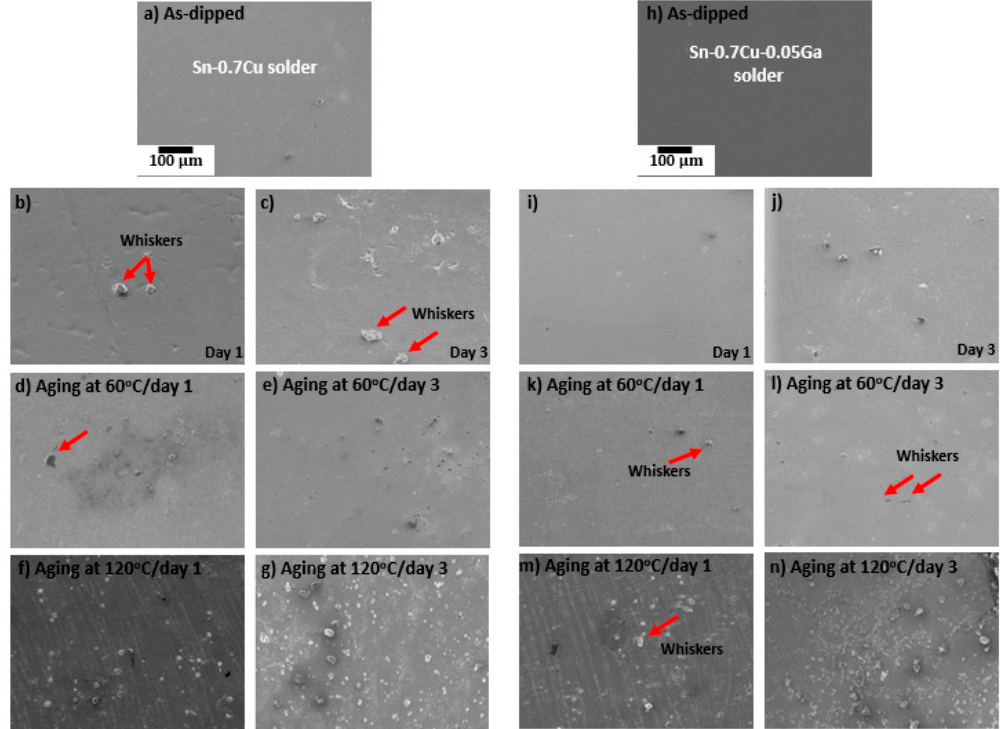
Figure 9. Whisker growth on Sn–0.7Cu: ( a ) as-dipped solder; after day 3 electromigration testing ( b , c ); after thermal ageing at 60 °C on day 1 and day 3 ( d , e ); after thermal ageing at 120 °C on day 1 and day 3 ( f , g ). Whisker growth on Sn–0.7Cu–0.05Ga: ( h ) as-dipped solder; after day 3 electromigration testing ( i , j ); after thermal ageing at 60 °C on day 1 and day 3 ( k , l ); after thermal ageing at 120 °C on day 1 and day 3 ( m , n ).